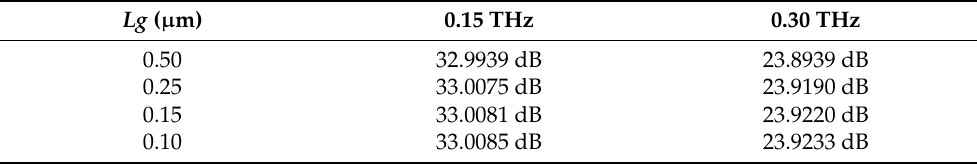
Figure 7. 3D view of the structure used in simulations showing the bonding wires. Table 3. Maximum value of the normalized electric field component along x axis in dB for frequencies 0.15 and 0.30 THz considering the effect of the bonding